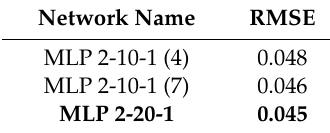
Table 5. The RMSE values for three MLP neural network (based on the cutting force